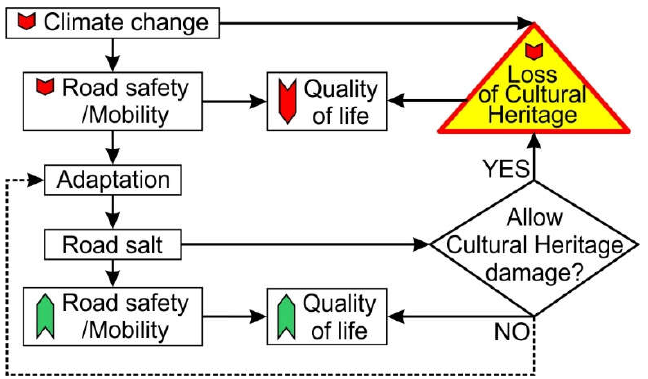
Figure 3. The insertion of cultural heritage into a simplified decision chain for road salt use. Coloured up or down arrows inside the text boxes indicate positive or negative trends or effects. Road salt decisions should include consideration of cultural heritage damage (the diamond) and a mechanism for feeding (dotted line) back into road safety climate change adaptation strategies. Institutional preconditions (barriers) may affect decision processes at any point in the model.